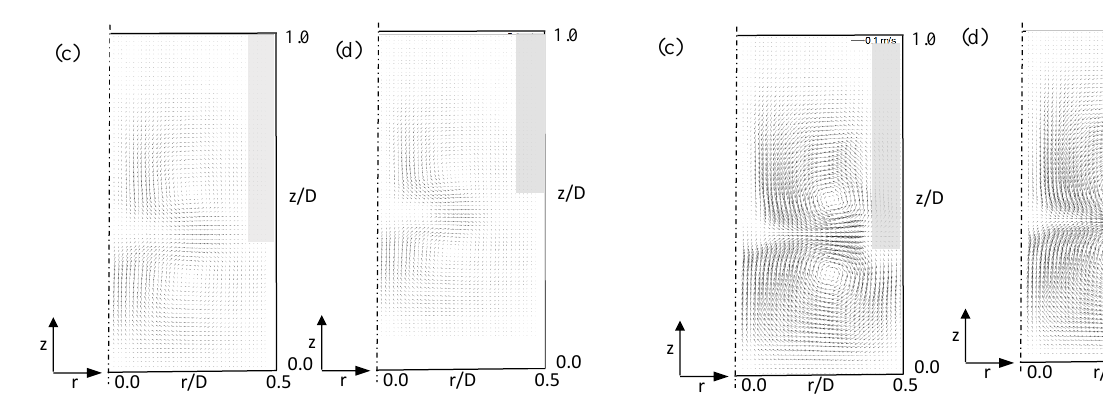
Fig. 4. Velocity field for h/H =1/3 Rushton turbine for rotational speed N =100 rpm and lenght of baffles: (a) L=H, (b) L=3/4H, (c) L=2/3H, (d) L=1/2H .